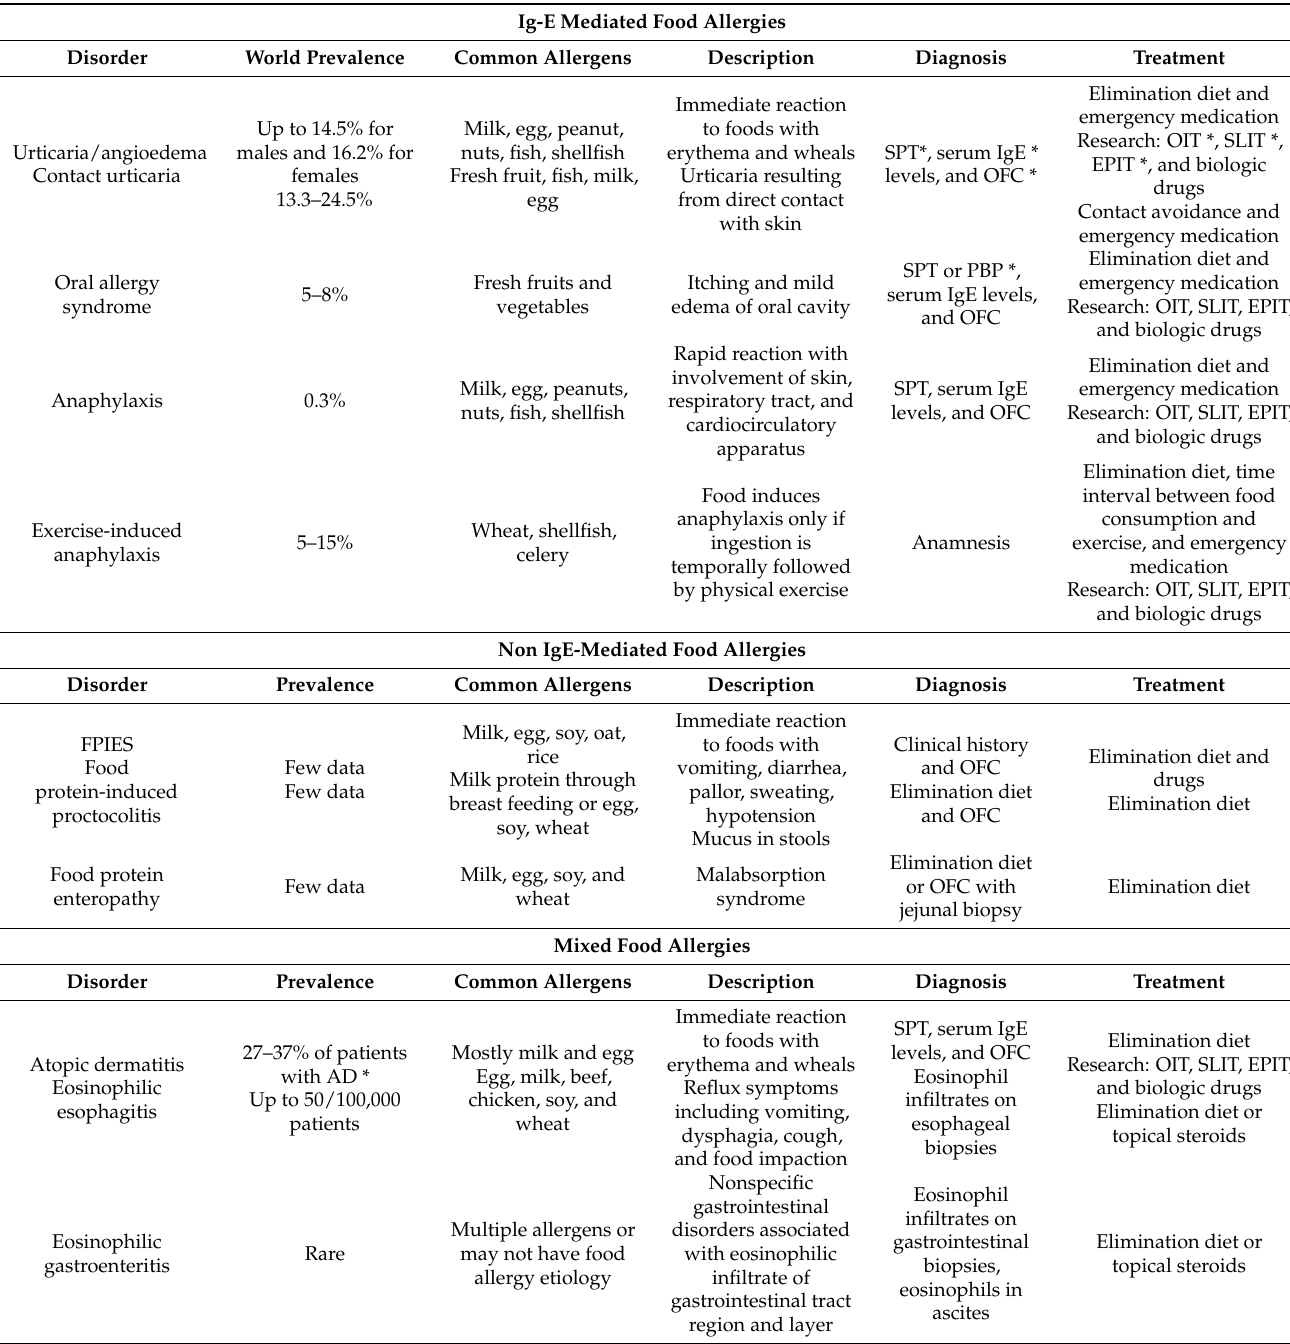
Table 1. Main clinical findings of Food Allergies in pediatric